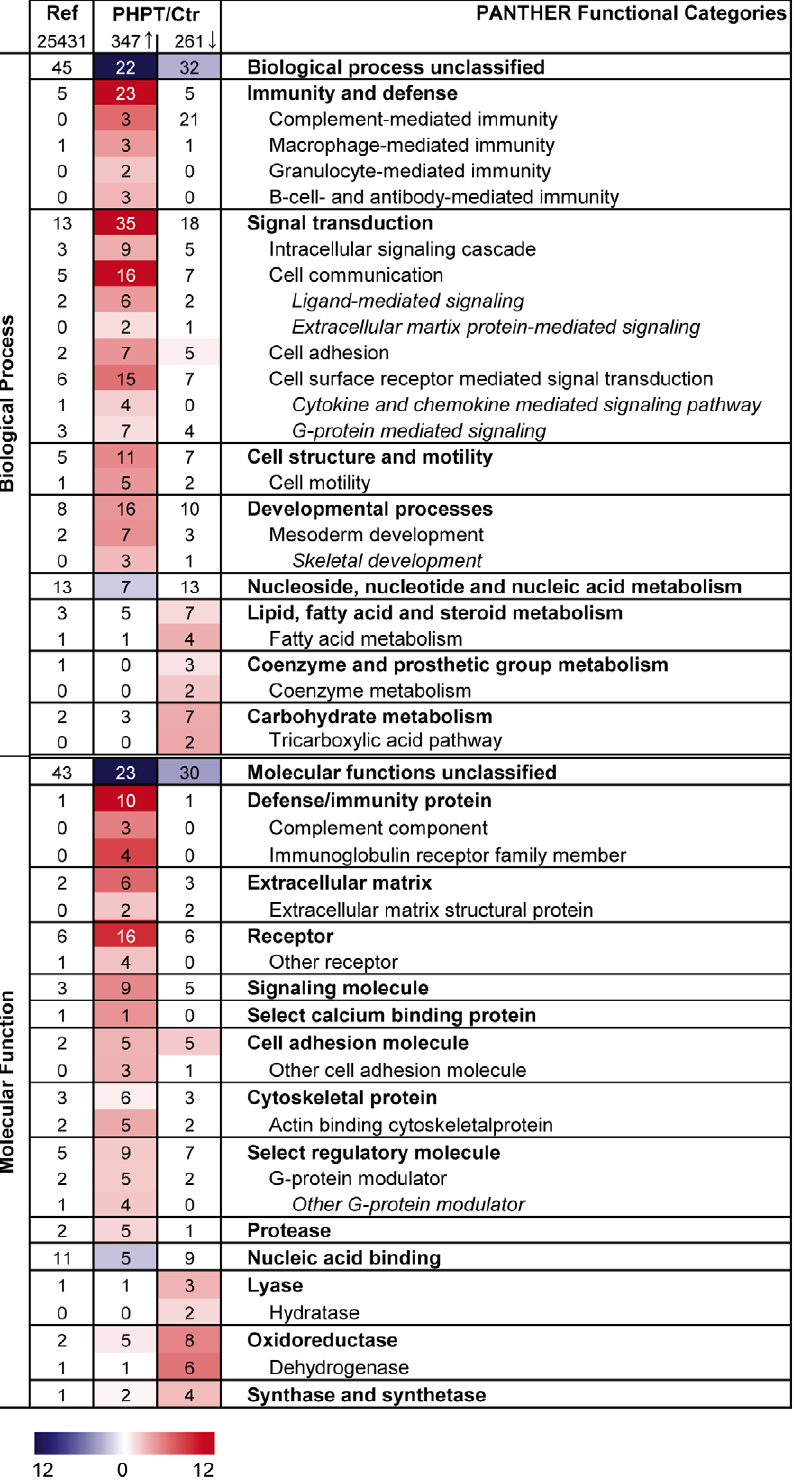
PLoS ONE | www.plosone.org